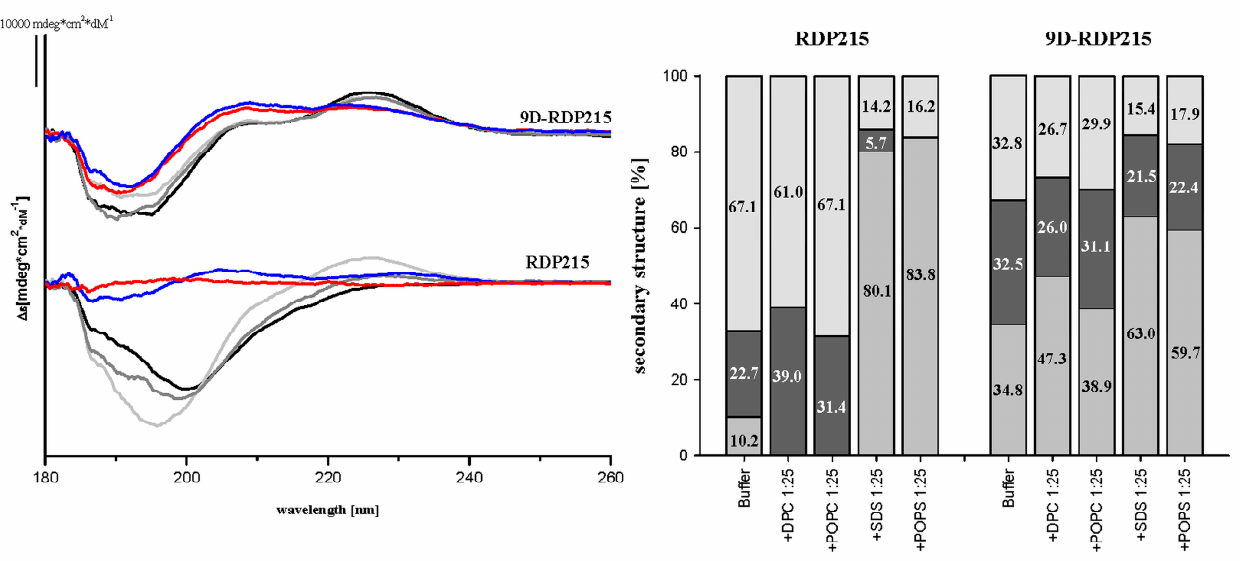
Figure 3. Circular Dichroism (CD) spectroscopy of RDP215 and 9D-RDP215. Investigation of peptide structures and their behavior in the presence of cancer mimics POPS/SDS and non-cancer mimics POPC/DPC. Left: CD spectra of RDP215 and 9D-RDP215 in sodium phosphate buffer (black lines) or the presence of DPC (light gray lines), POPC (dark gray lines), SDS (blue lines) and POPS (red lines) at peptide to surfactant ratios of 1:25. Right: Secondary structures calculated from CD spectra using Spectra secondary structure estimation [45]. The β -turns are shown in middle gray; turns are shown in dark gray; random coil structures are shown in light gray at the top. RDP215 and 9D-RDP215 are specific peptides and change their secondary structure only in the presence of the cancer mimics POPS and SDS. The substitution of D-amino acids does not alter the general structural conformation behavior of the peptides, though the structured part in solution is increased. Data represent the outcome of three independent experiments.